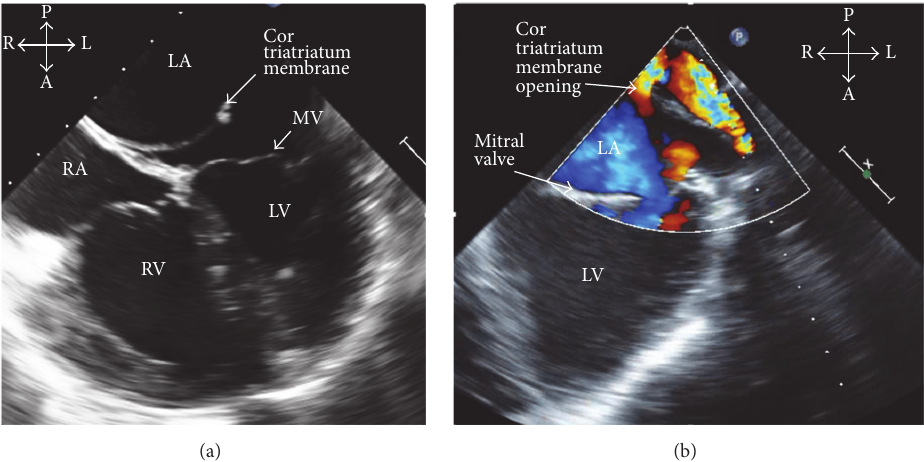
Figure 3: Transesophageal echocardiogram (a) is a midesophageal four-chamber view demonstrating cor triatriatum with a membrane separating the pulmonary veins from the left ventricle inflow and (b) is a midesophageal two-chamber view with Doppler flow demonstrating restrictive flow through the opening of the cor triatriatum membrane. LV: left ventricle, RV: right ventricle, LA: left atrium, RA: right atrium, MV: mitral valve, S: superior, I; inferior, R: right, L: left, A: anterior, and P: